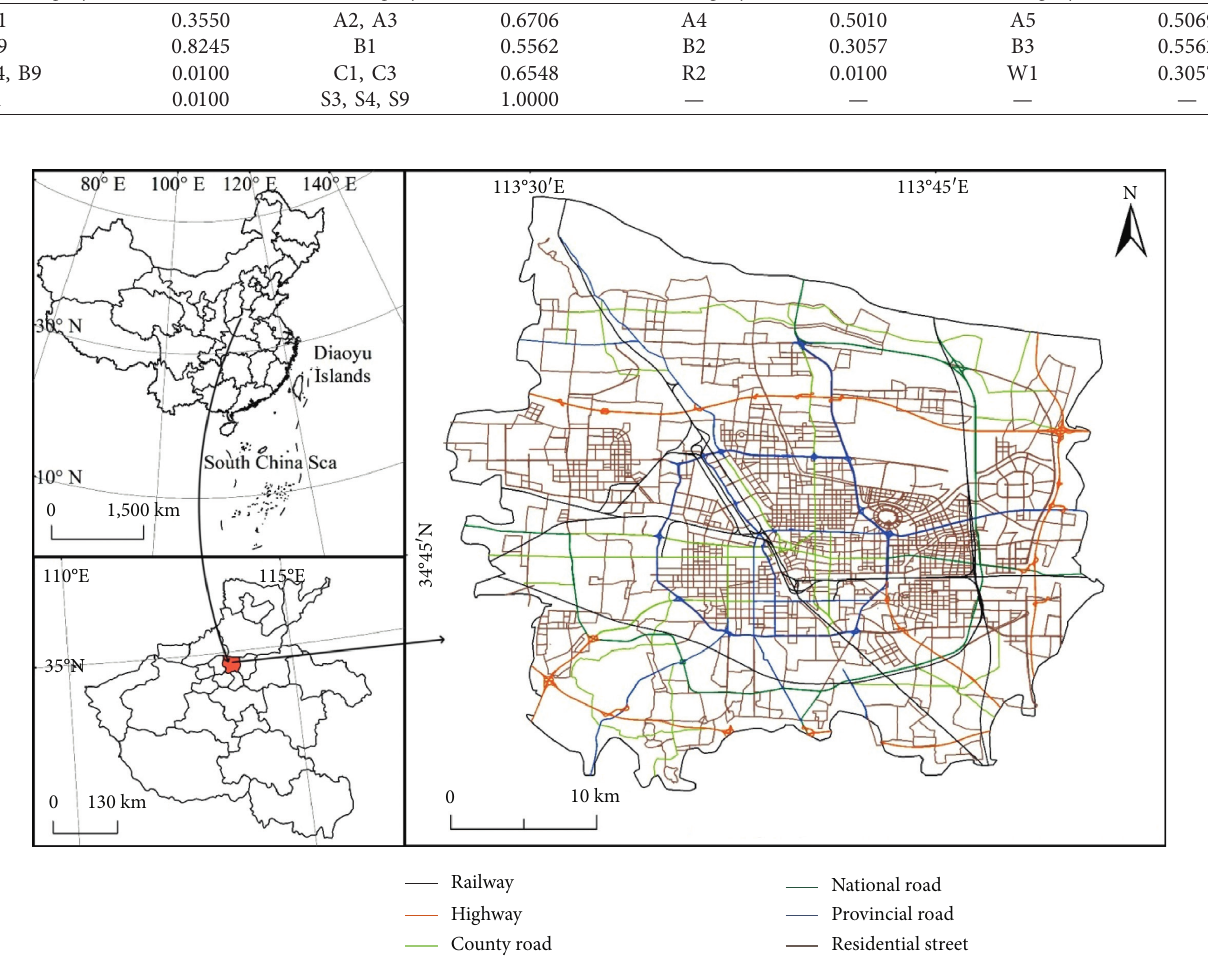
Figure 1: Location of the study area.